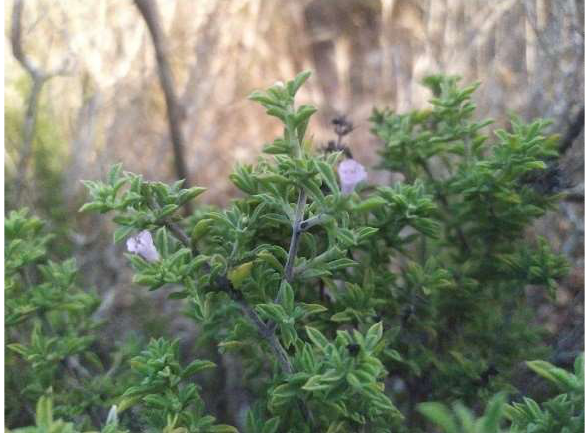
Figure 1. Palestinian Satureja capitata (Thymbra) .